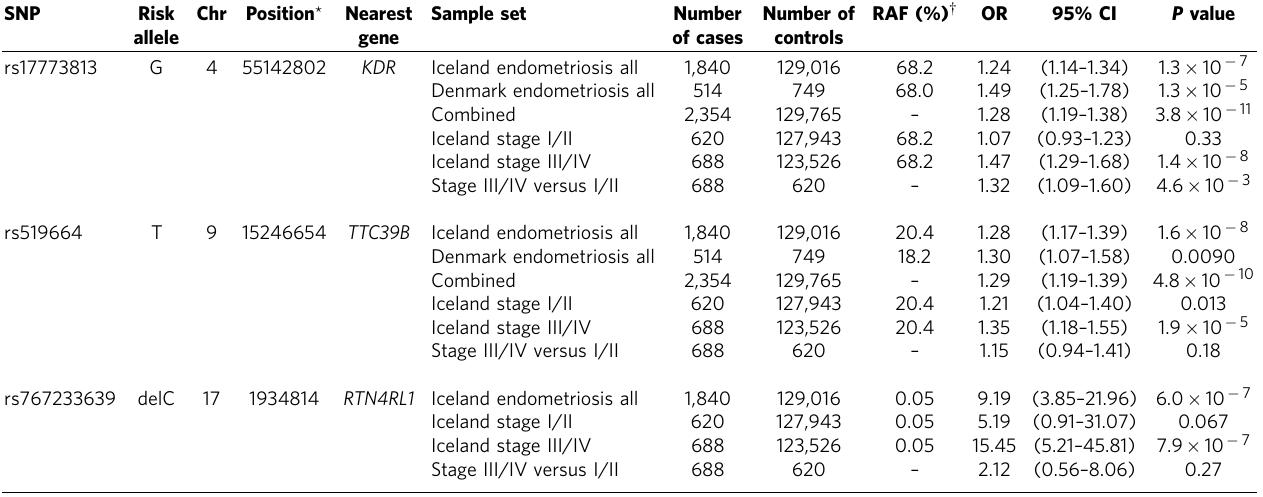
Table 1 | Association of sequence variants near KDR and in TTC39B and RTN4RL1 with endometriosis. SNP Risk Chr Position * Nearest Sample set Number allele gene